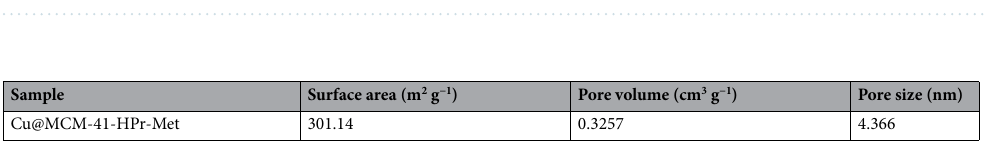
Figure 7. ( A ) Adsorption/desorption N 2 isotherms and ( B ) pore size distribution of Cu@MCM-41-HPr-Met.